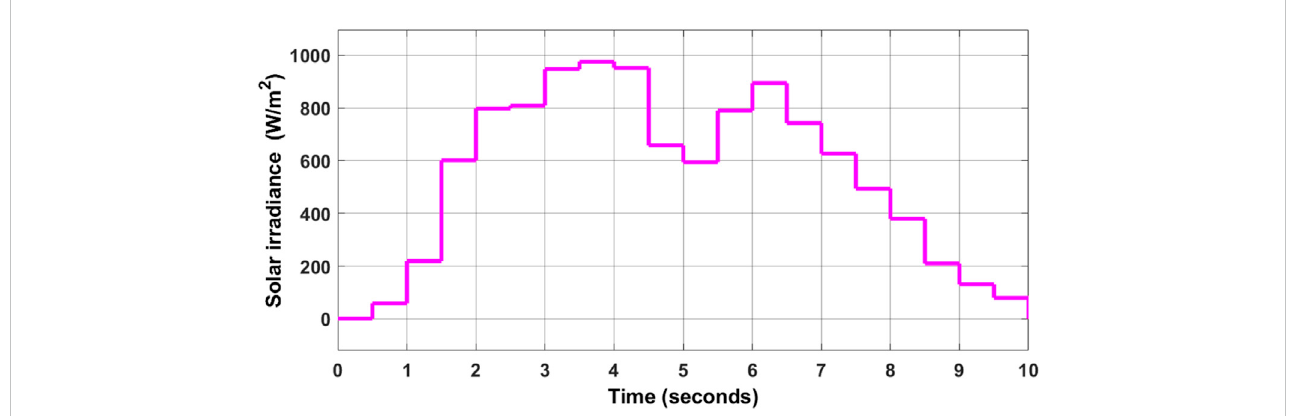
FIGURE 8 The solar irradiance pro fi le used in this study.